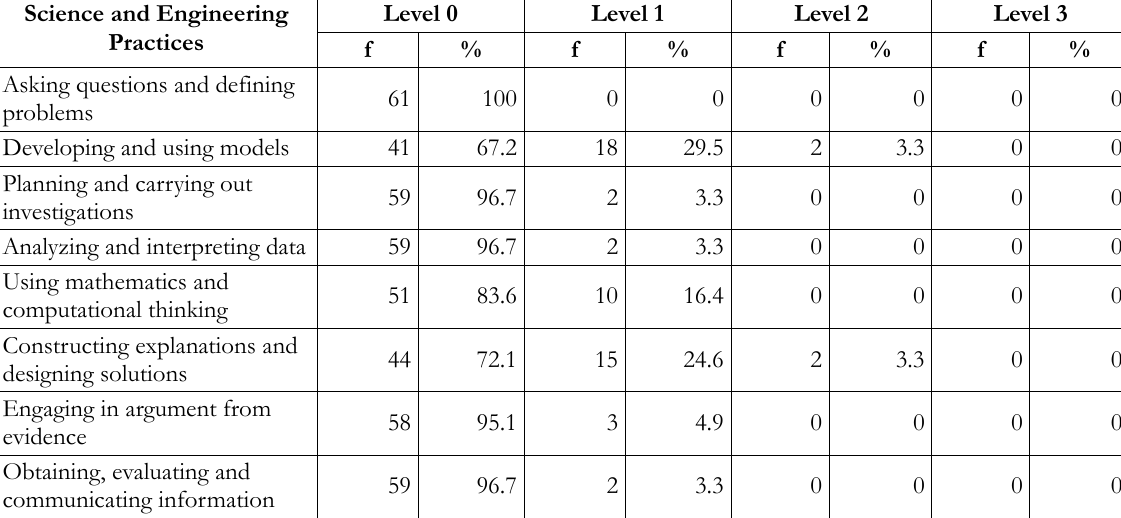
Table 2. Frequencies and Percentages of Practice Levels in Reports and Activities of Greek Middle School